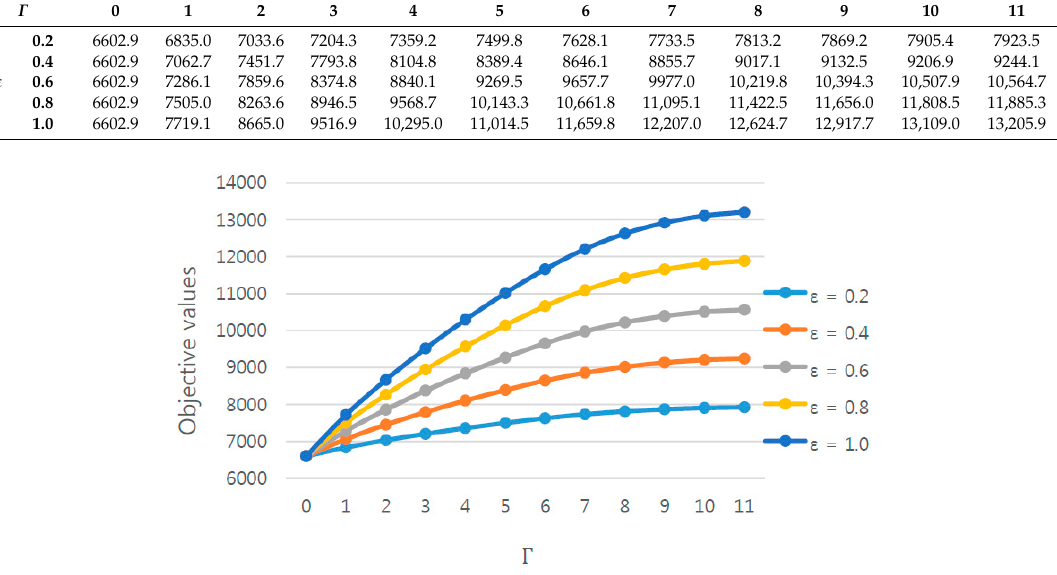
Figure 2. Comparison of objective values corresponding to the minimum and maximum values of the uncertainty degree ( n = 12).